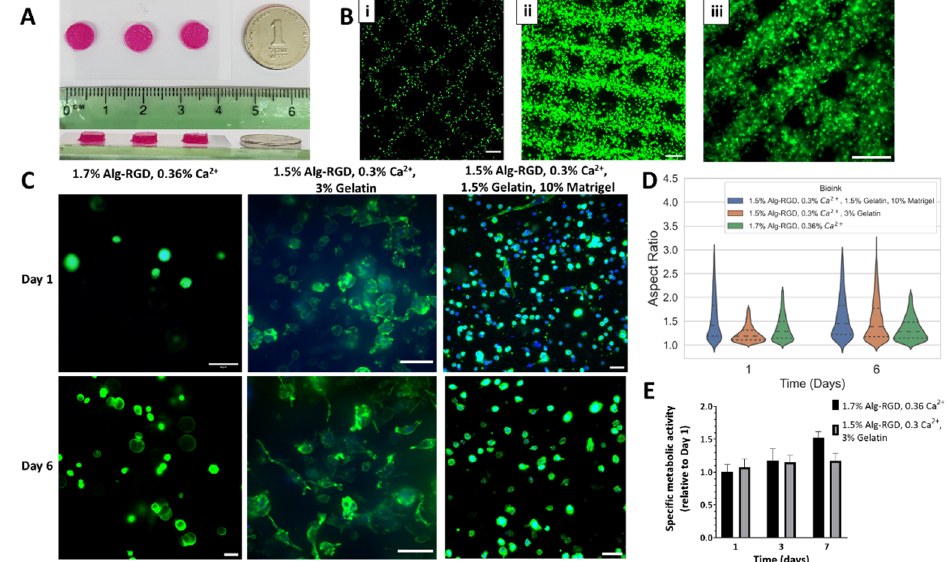
Figure 3. Three-dimensional bio-printing optimization of cardiac patch core. ( A ) Images of Alg-RGD cell-laden constructs, fabricated by 3D bio-printing. ( B ) Representative confocal images of 3D bio-printed strands using cell-laden bioink solutions, showing GFP-expressing human fibroblasts (HF-GFP) distribution (in green). (i) 1.7% Alg-RGD, 0.36% Ca 2+ ; (ii) 1.5% Alg-RGD, 0.3% Ca 2+ , 3% gelatin; (iii) 1.5% Alg-RGD, 0.3% Ca 2+ , 1.5% gelatin, 10% Matrigel. Scale bar: 500 µm. ( C ) High magnification images of 3D bio-printed HF-GPF encapsulated in different bioink solutions, at day 1 (top) and 6 (bottom) post-printing. Nuclei: blue. F-actin: green. Scale bar: 50 µm. ( D ) Quantitative image analysis of cells’ aspect ratio distribution, printed within different bioink solution. Data represented in quartiles. ( E ) Specific metabolic activity of printed HF-GFP within 3D bio-printed constructs over time.